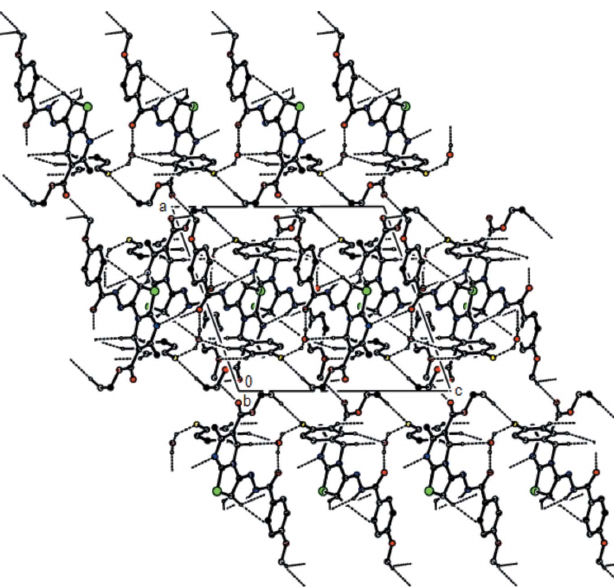
Figure 3 View of the molecular packing along [010]. Hydrogen bonds are depicted as in Fig. 2.